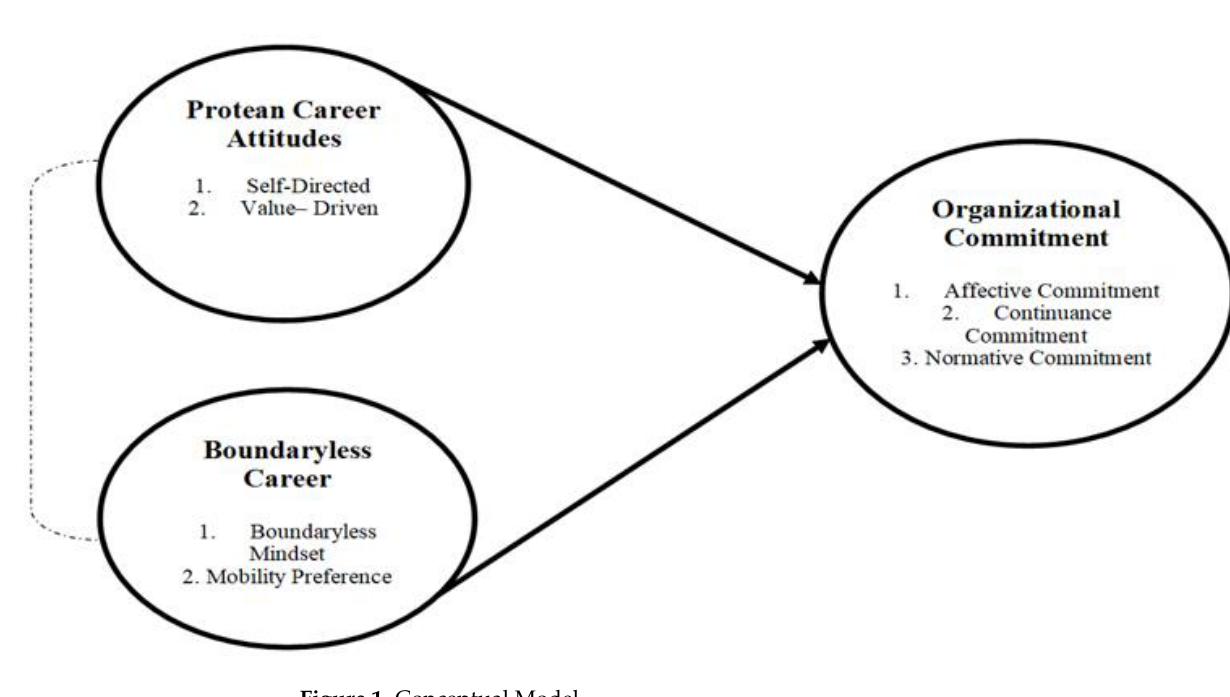
Figure 1. Conceptual Model.